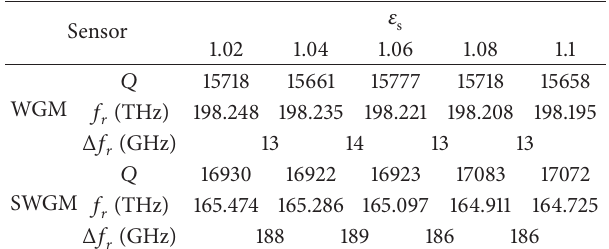
Table 1: 𝑄 factor, resonant frequency, and frequency shift of WGM sensor and SWGM sensor